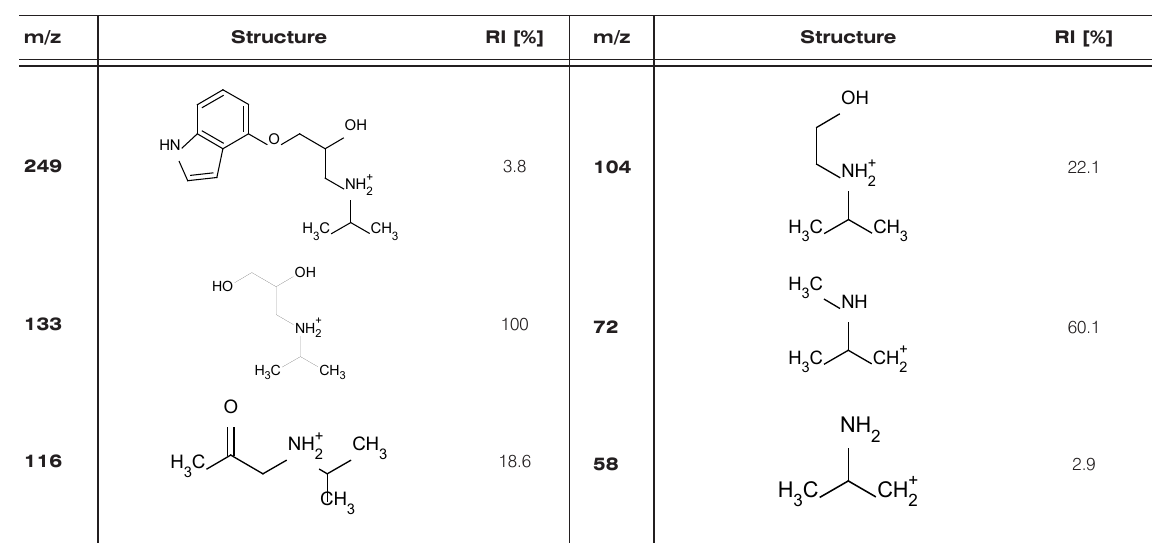
Table 3. Proposed structures of some fragment ions in the MS spectrum of